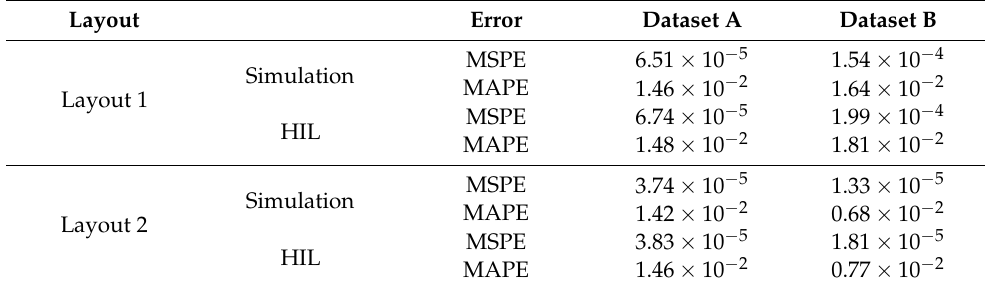
Table 5. Estimation accuracy analysis, in terms of MSPE and MAPE.